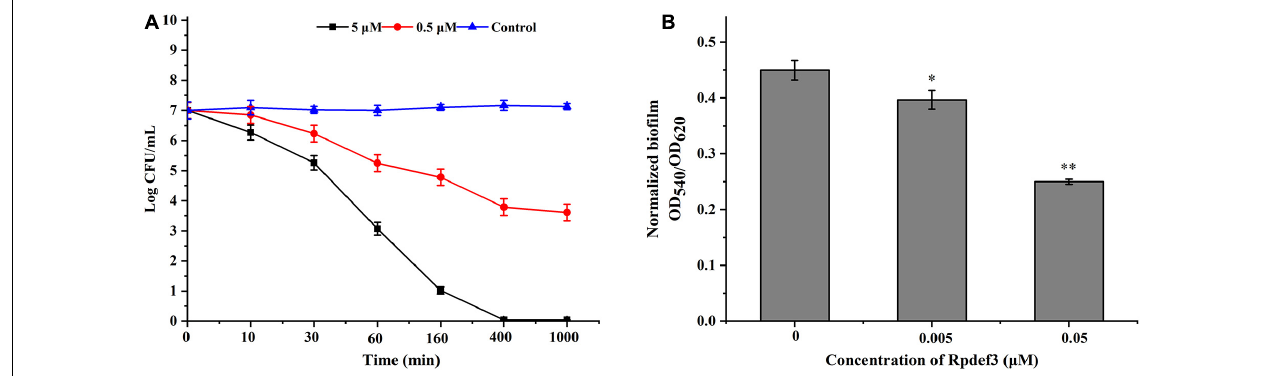
FIGURE 4 | Antibacterial activities of Rpdef3. (A) Bacterial killing kinetics of Rpdef3 at 0.5 and 5 µ M against E. coli. Each group had three replicates. (B) Biofilm formation of E. coli MG1655 treated with Rpdef3. Normalized biofilm formation (total biofilm/growth) was tested in 96-well polystyrene plates after treated with Rpdef3. Data were the average of 10 replicate wells from two independent cultures. The values were shown as mean ± S.D. ( N = 10) ( ∗ P < 0.05; ∗ ∗ P < 0.01).